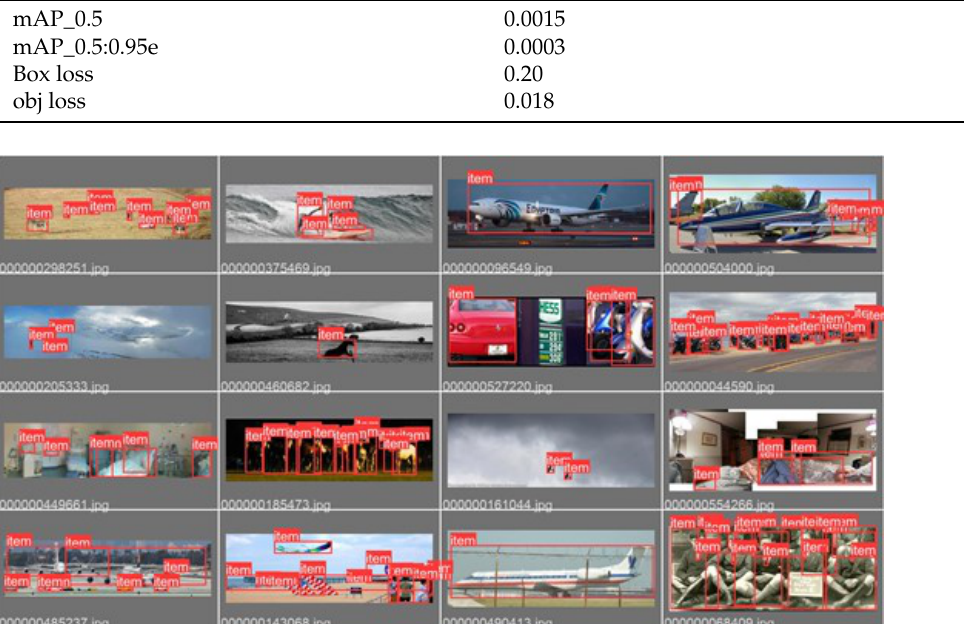
Table 4. Validation on SEAGULL and COCO combination—values of metrics.